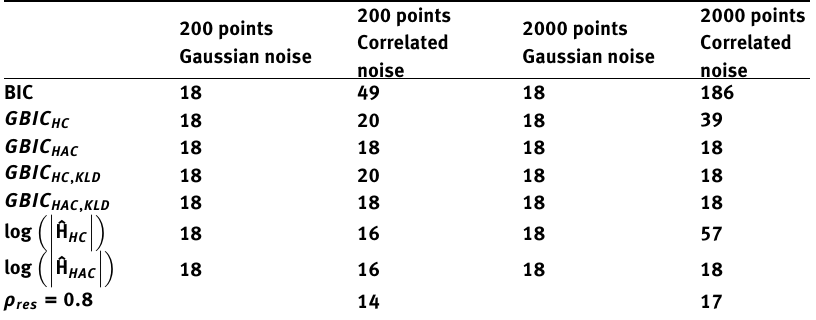
Table 1. Number of CP leading to the minimum value of each IC. 200 and 2000 points were generated and a Gaussian and a correlated noise (AR(1) with ρ = 0.8) were added to the simulated